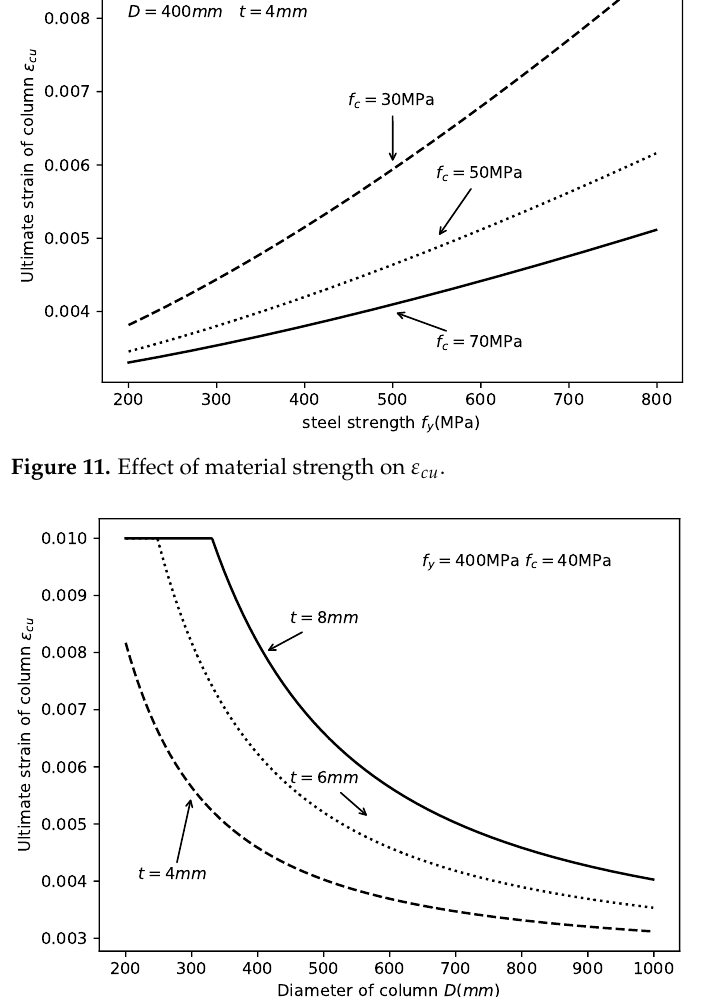
Figure 12. Effect of dimensions on ε cu